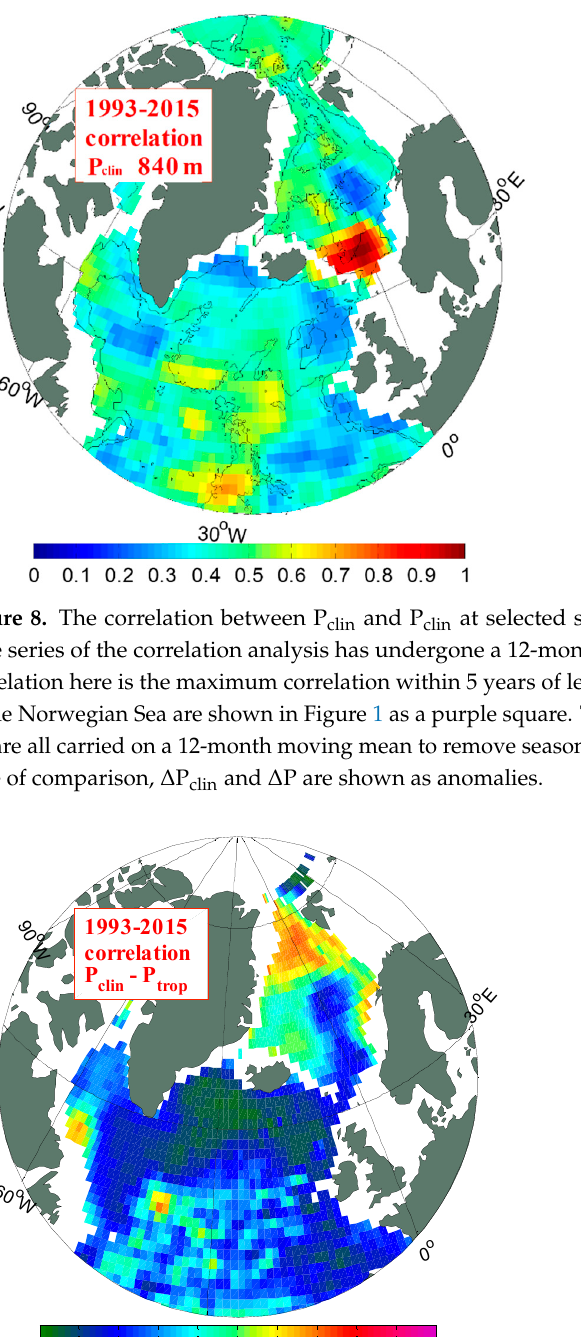
Figure 7. The variation ( a ) and the correlation for different lag time lengths ( b ) of ∆ P trop and ∆ P clin .